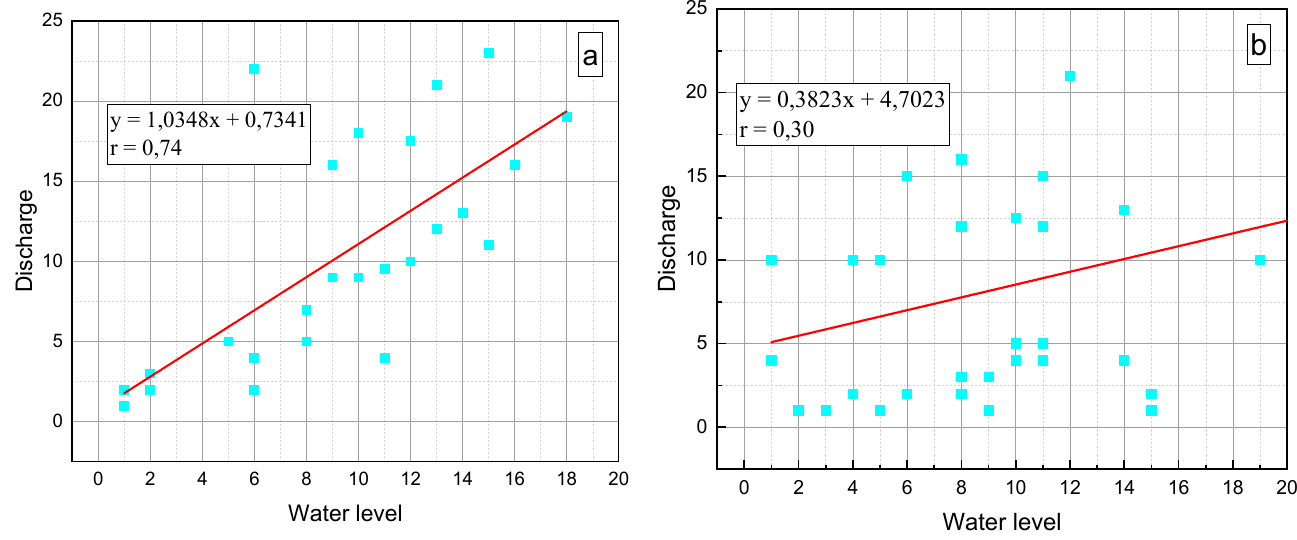
Figure 10. Spearman rank correlation coefficient between the lake water level and the Temnik runoff: ( a )—before, and ( b )—after launch of the Gusinoozersk GRES.